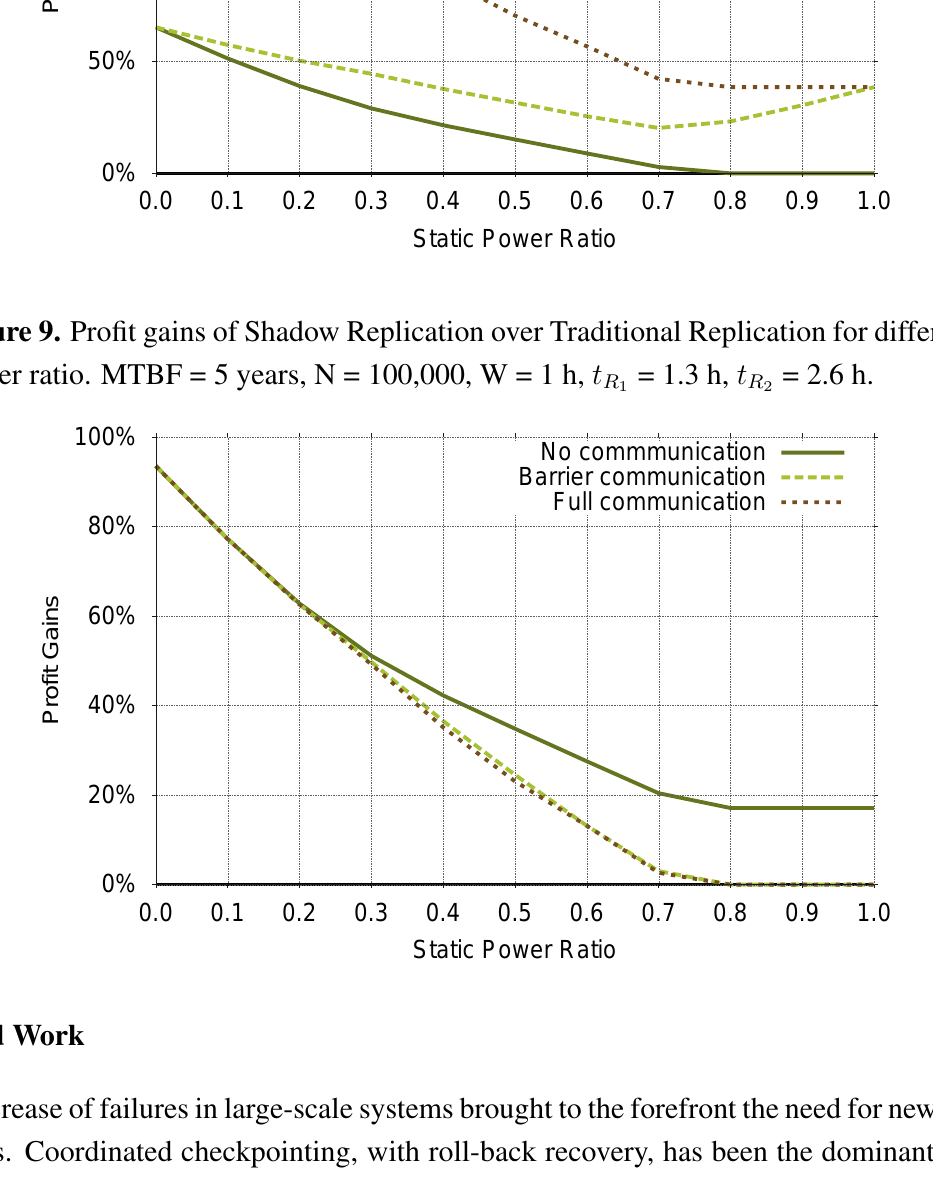
Figure 8. Profit gains of Shadow Replication over Re-execution for different static power ratio. MTBF = 5 years, N = 100,000, W = 1 h, t